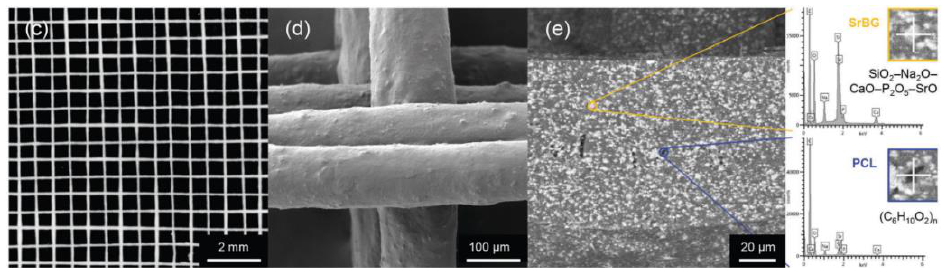
Figure 11. ( a ) Schematic diagram of the MEW process using an applied pressure ( ∆ P) to extrude a molten polymer or polymer solution through a nozzle with a radius R and a length L to a moving collector plate. ( b ) Visualization of the MEW device. ( c – e ) SEM image of microfiber morphology. Reproduced from [165].